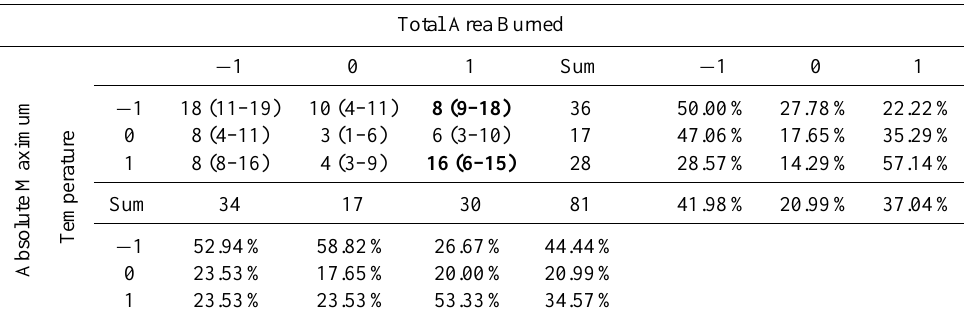
Table 1. Cross-tabulation results between burned area and absolute maximum air temperature. Monte Carlo randomization confidence limits are in parentheses. Values in bold are statistically significant.